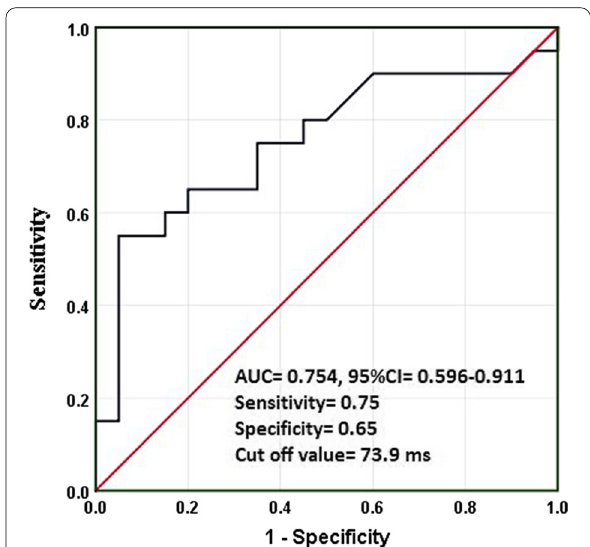
Fig. 1 Receiver operating characteristic curve for CuSP onset in the context of discrimination between patients and controls